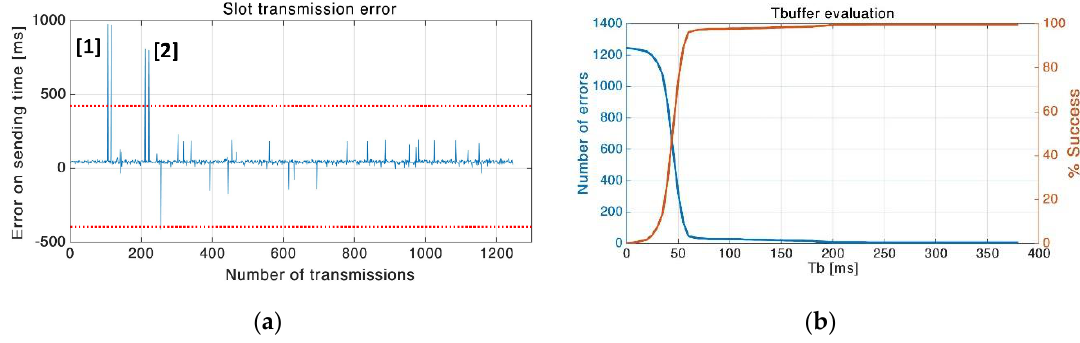
Figure 14. ( a ) Synchronization error in ms respect to the beginning of each slot. The maximum error allowed is 400 ms, which is exceeded five times. Two overflows are generated from end node reboot due to firmware issues; ( b ) number of slots overlapped as a function of tolerance interval length.